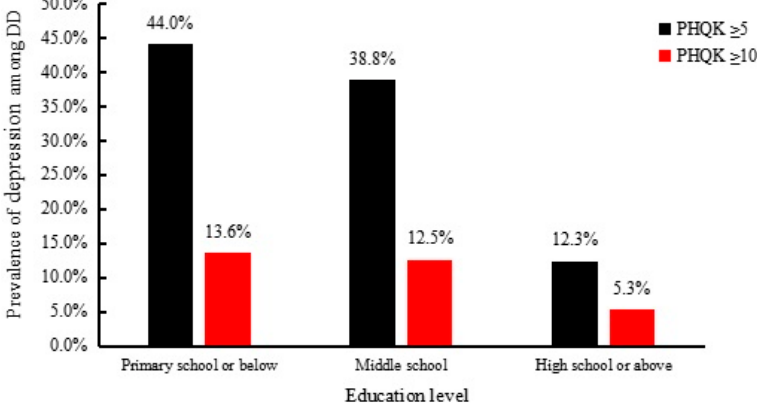
Figure 1. Prevalence of depression in different groups ( p < 0.001). Abbreviations: ND: No diabetes; DD: Diagnosed diabetes; UD: Undiagnosed diabetes; PHQK: Patient health questionnaire score.